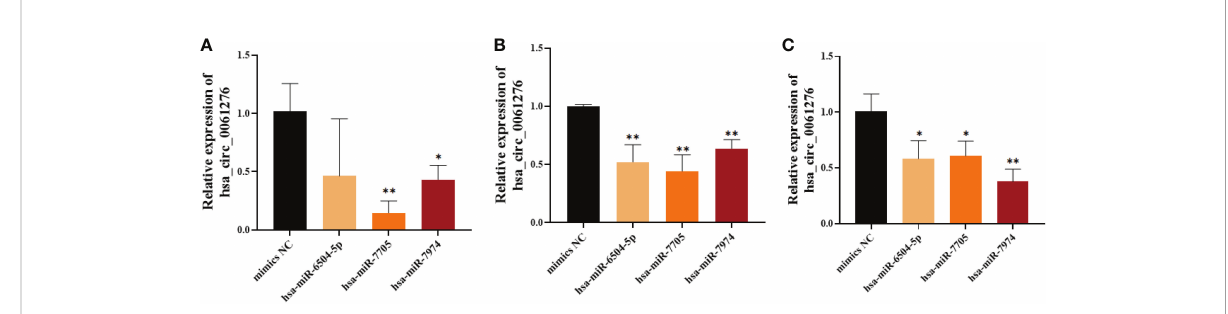
FIGURE 5 The expression of hsa_circ_0061276 in gastric cancer cells after transfection with miRNA mimics. (A) Twenty- fi ve picomolar miRNA mimics. (B) Fifty picomolar miRNA mimics. (C) Seventy- fi ve picomolar miRNA mimics. * p < 0.05, ** p < 0.01; n = 3. Independent samples t -test (two-tailed).